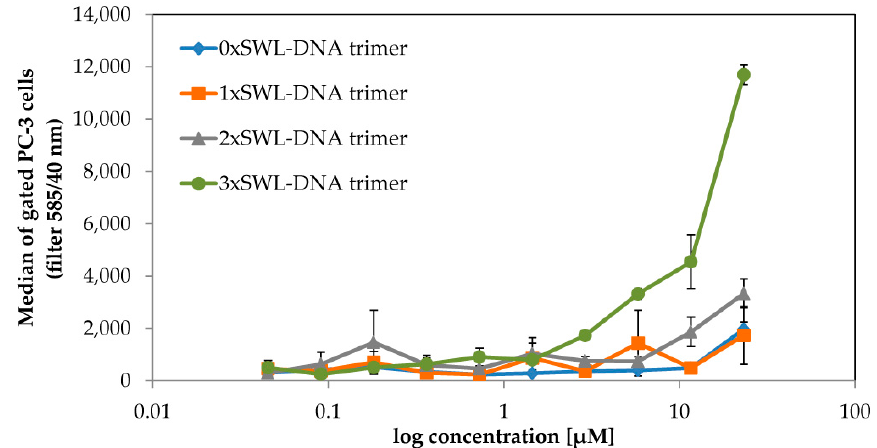
Figure 2. Binding of SWL-coupled DNA trimers to EphA2-expressing PC-3 cells. Serum-starved PC-3 cells were treated with SWL-DNA trimer constructs (labeled with Cy3, carrying 0-3 peptides SWL) in duplicates for 30 min at room temperature. Cells were gated and normalized by cell number. Displayed on the y-axis are average values of emission which were observed using a 585/40 nm filter (FL2-A) with standard deviation presented as error bars. The x-axis indicates concentrations of the constructs in terms of DNA. Scatter plots of raw data can be found in Figure A6.